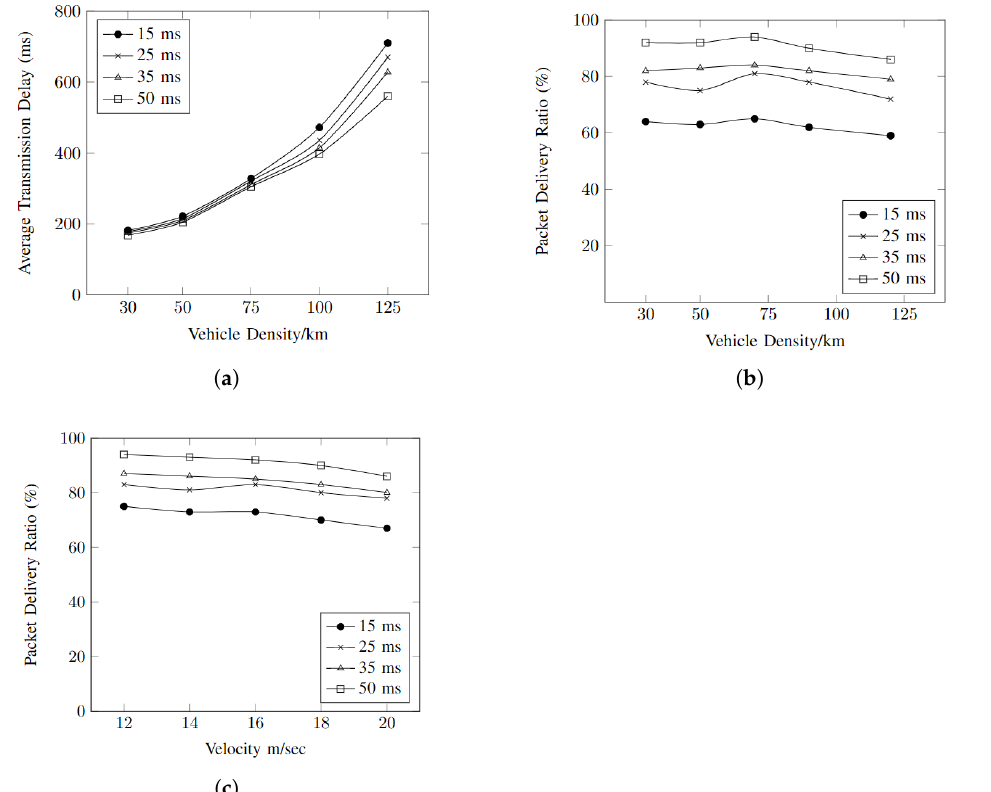
Figure 6. Multi-BSM evaluated in accordance with different intervals of BSM generations. ( a ) Average transmission delay vs. vehicle density. ( b ) Packet delivery ratio vs. vehicle density. ( c ) Packet delivery ratio vs. velocity.